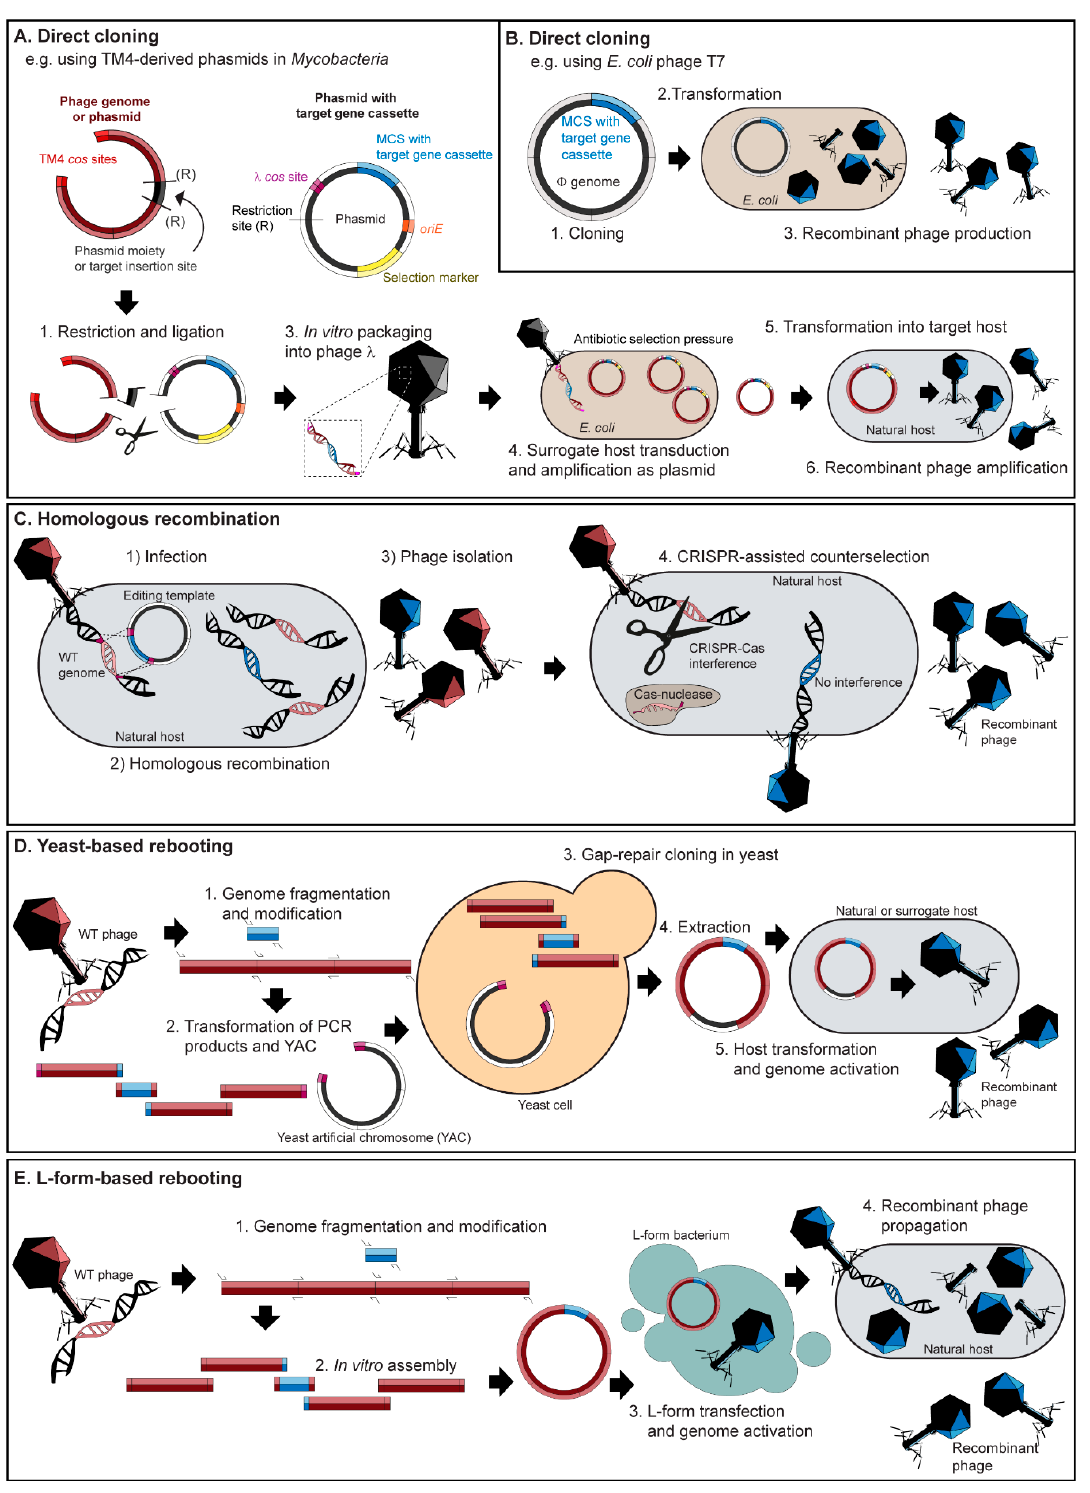
Figure 2. Overview of engineering strategies for reporter phage generation. ( A ) Heterogeneous reporter genes can be inserted into dual function shuttle phasmids capable of plasmid replication in E. coli and phage replication in a target host, e.g., Mycobacterium spp. ( B ) Reporter genes can also be directly inserted into phage genomes, e.g., T7Select ® (Novagen). ( C ) Homologous recombination (and recombineering with bacteriophage-encoded homologous recombination systems, such as the coliphage λ Red system) involves the swapping of a reporter gene containing homology arms featured on an editing plasmid with the homologous region located within a phage genome. Homologous recombination can be combined with CRISPR-Cas counter selection to facilitate the removal of wild-type phages to improve identification of recombinant phages. ( D ) PCR products of